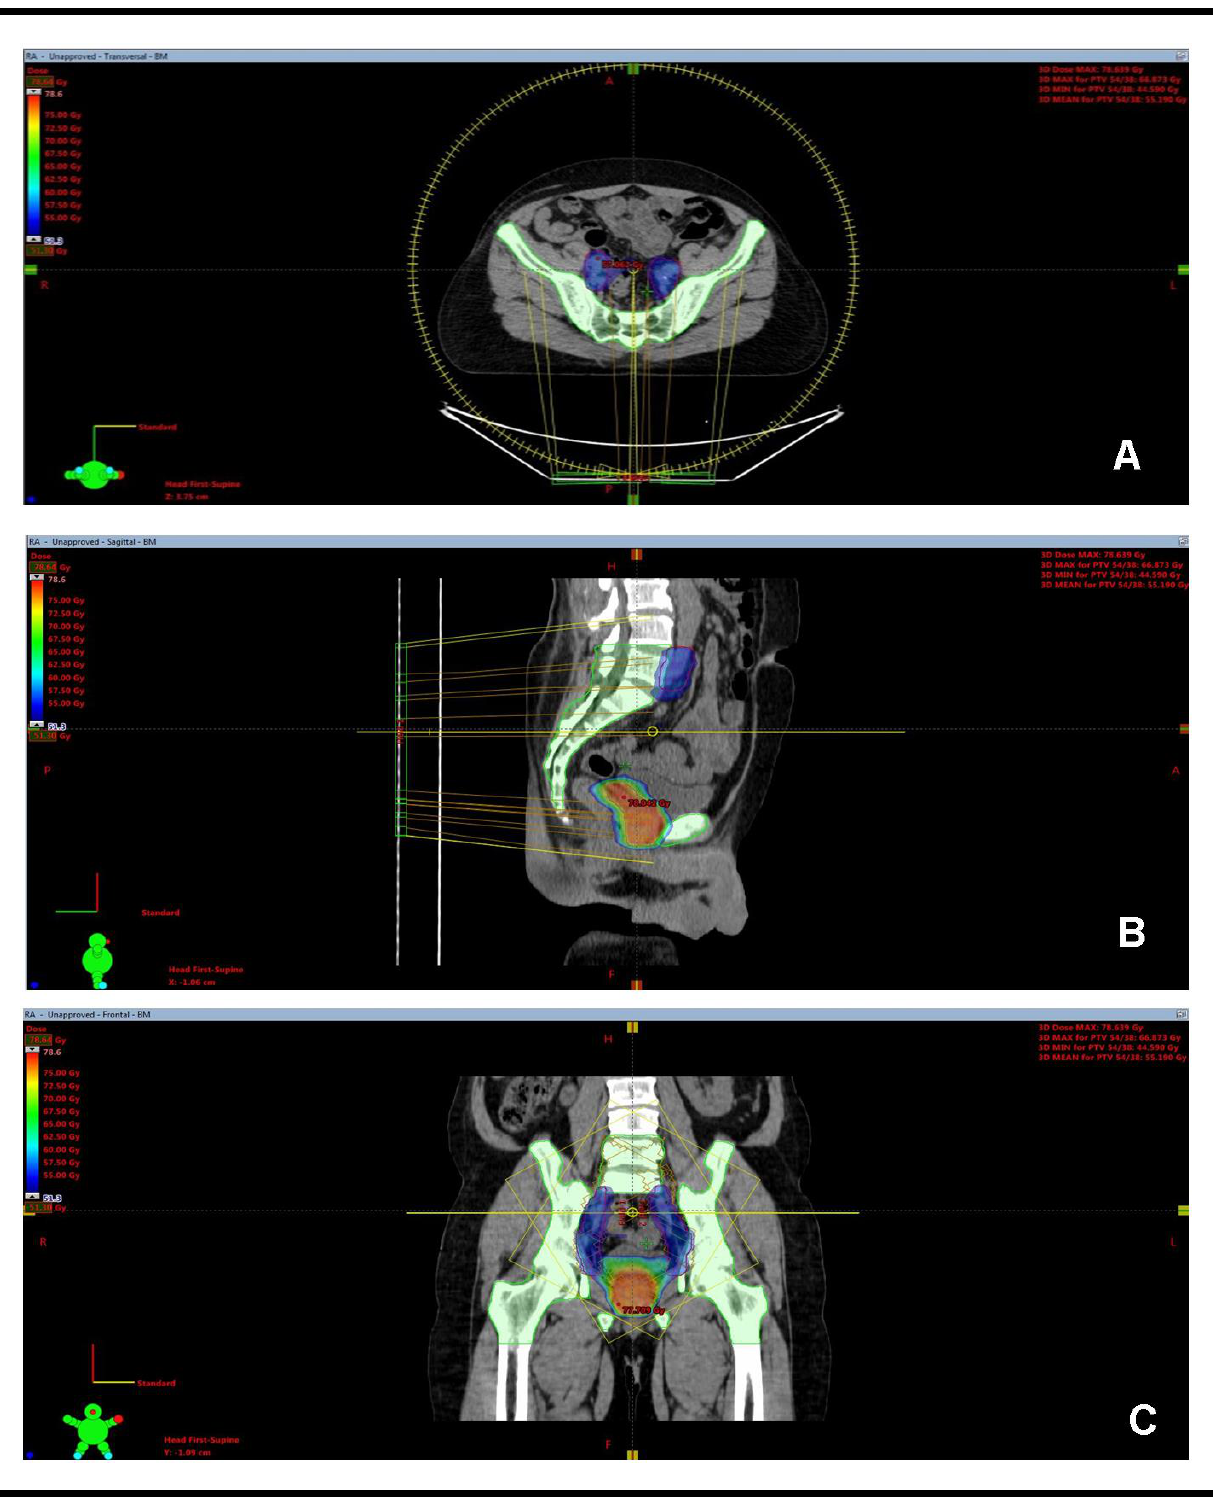
Figure 2: Dose distribution of volumetric-modulated arc therapy (VMAT) plan in one patient: A) Axial, B) Sagittal and C) Coronal